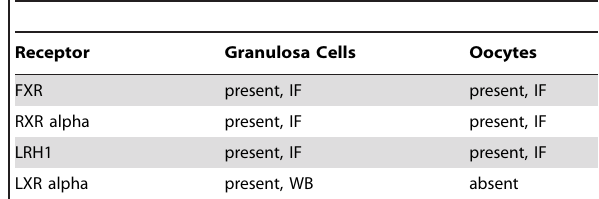
Figure 3. Bile acid production in primary cultured human cumulus granulosa cells (CGC). Cholesterol entering granulosa cells may be used to form sex steroids or bile acids (Panel a). With increasing cholesterol concentration in media, CGC demonstrate dose-dependent bile acid content (Panel b).